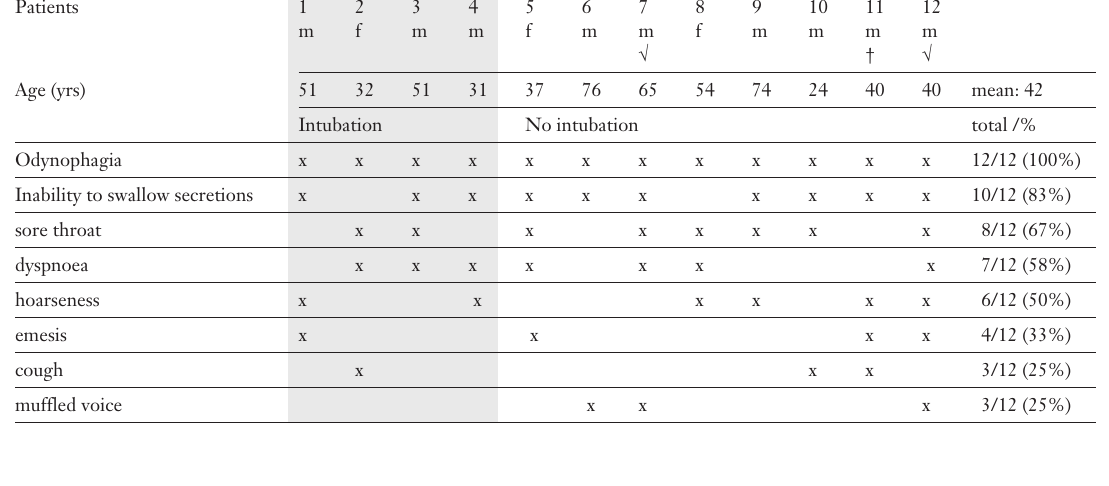
Signs of patients with acute epiglottitis (n = 12). † patient who died, √ correct diagnose when